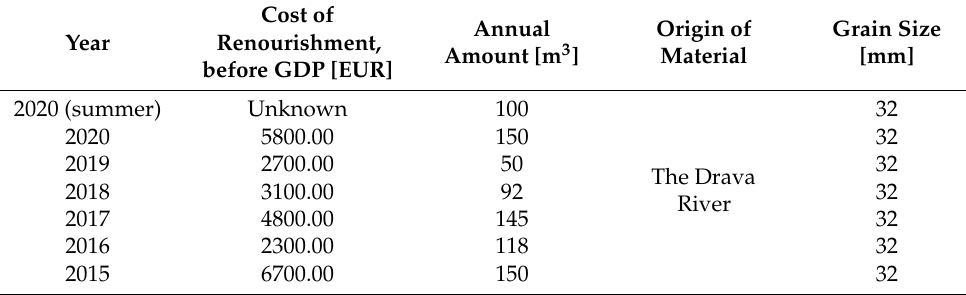
Figure 2. Study site ( top ) before the construction [52] and ( bottom ) after construction. Table 1. Annual cost of renourishment for the Ploˇce